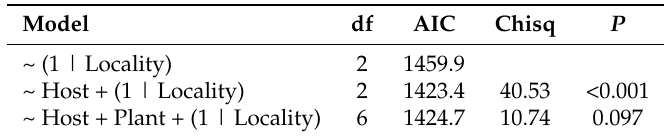
Table 6. Generalized mixed model indicating differences in relative proportion of undeveloped lestid eggs in relation to host species and oviposition plant.